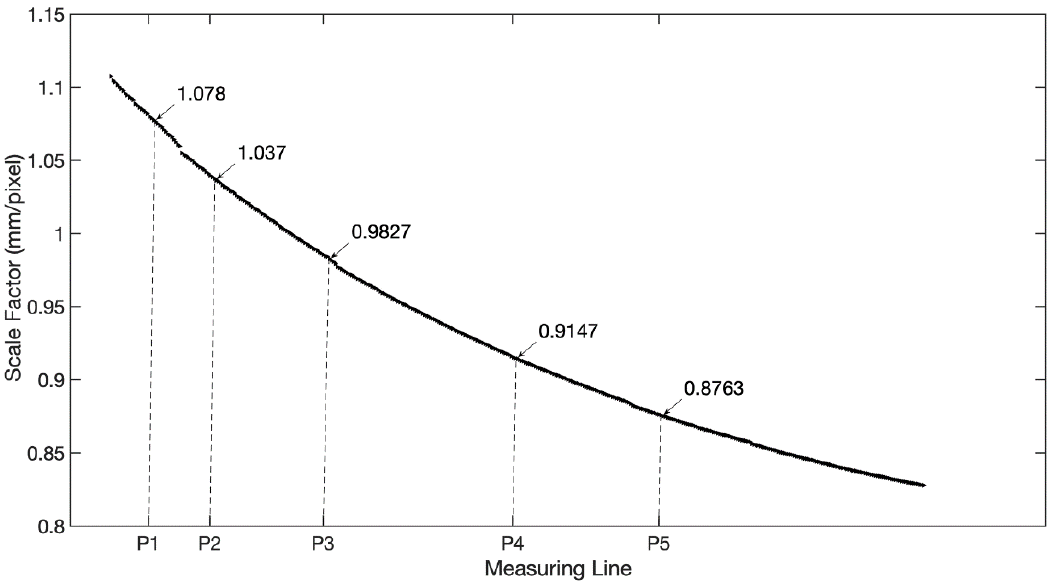
Figure 7. Measurement of a cantilever beam subjected to static loads.